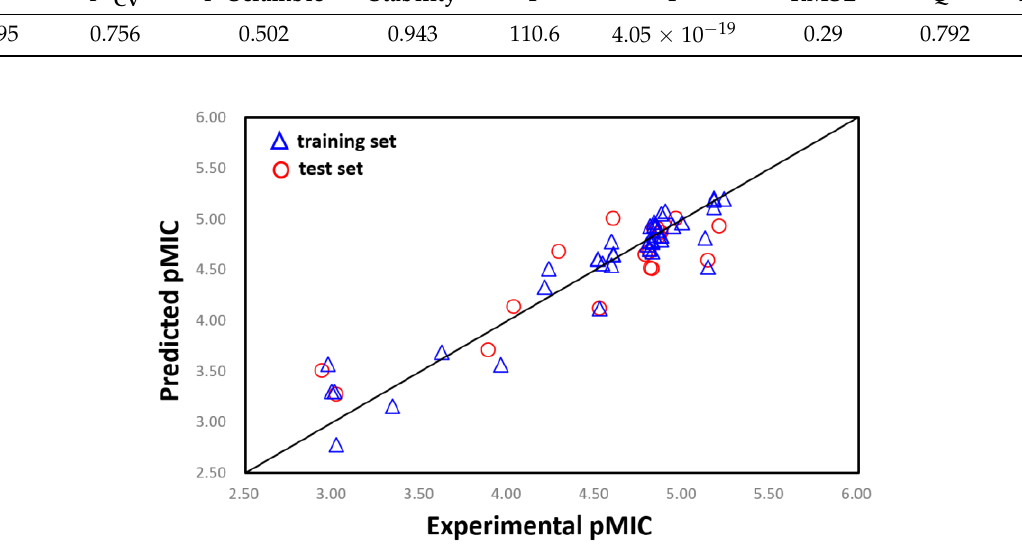
Figure 4. Plots of the predicted pMIC versus observed pMIC values by 3D QSAR model.